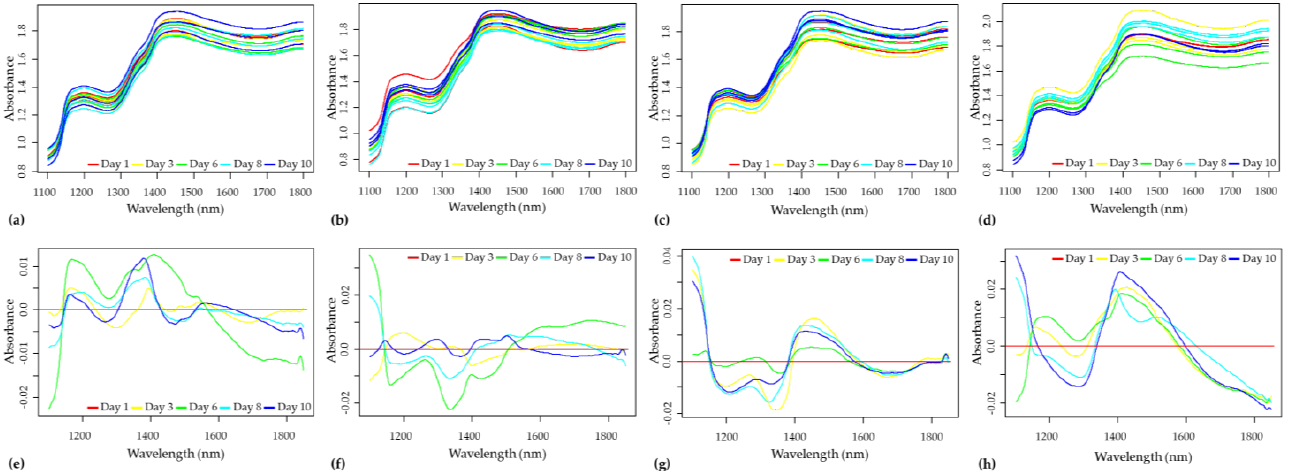
Figure 8. Raw spectra collected on ‘Kántorjánosi’ samples during the 10 days of storage: ( a ) Control samples stored at 3 °C; ( b ) Control samples stored at 5 °C; ( c ) MAP samples stored at 3 °C; ( d ) MAP samples stored at 5 °C. Average difference spectra of ‘Kántorjánosi’ samples calculated on storage days: ( e ) Control samples stored at 3 °C; ( f ) Control samples stored at 5 °C; ( g ) MAP samples stored at 3 °C; ( h ) MAP samples stored at 5 °C.